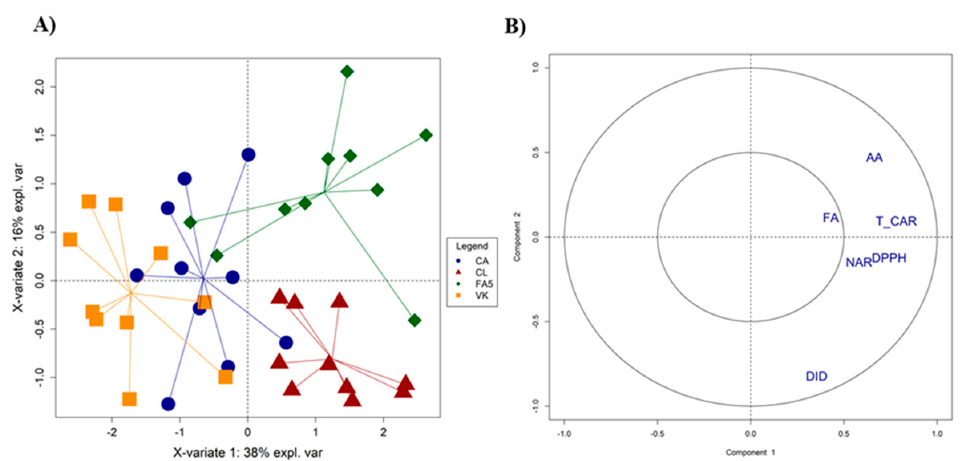
Figure 1. ( A ) Multilevel partial least squares discriminant analysis (ML-PLS-DA) scores plot of two first components performed on `Salustiana´ orange samples to evaluate the rootstock effects. Color and figure indicate the rootstocks: red triangles for `Cleopatra mandarin´ (CL), blue circles for Carrizo citrange (CA), yellow square for Citrus volkameriana (VK), and green diamond for Forner-Alcaide no.5 (FA5). ( B ) ML-PLS-DA loadings plot of the compounds selected in the iteration procedure in